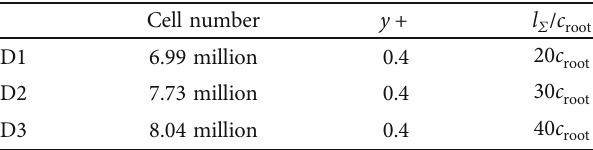
Table 3: Domain size study setup.